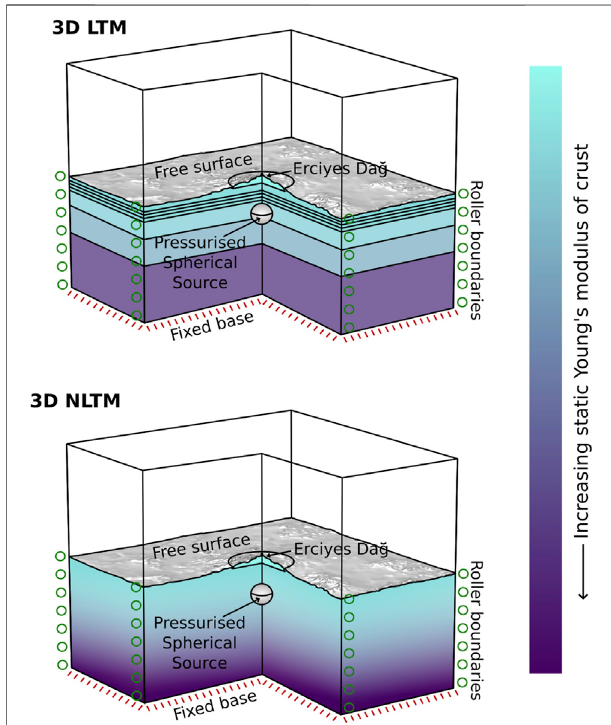
FIGURE 4 | Schematics of 3D model setups for the heterogeneous layered and non-layered TOPO models (LTM and NLTM) including applied domain boundary conditions. Whilst the subsurface of the layered model contains discrete mechanical layers throughout the crust, the non- layered model comprises gradually varying mechanical properties. The two modelsdenoteend-memberimplementationsofaheterogeneousmechanical crustal structure beneath Erciyes Da ğ